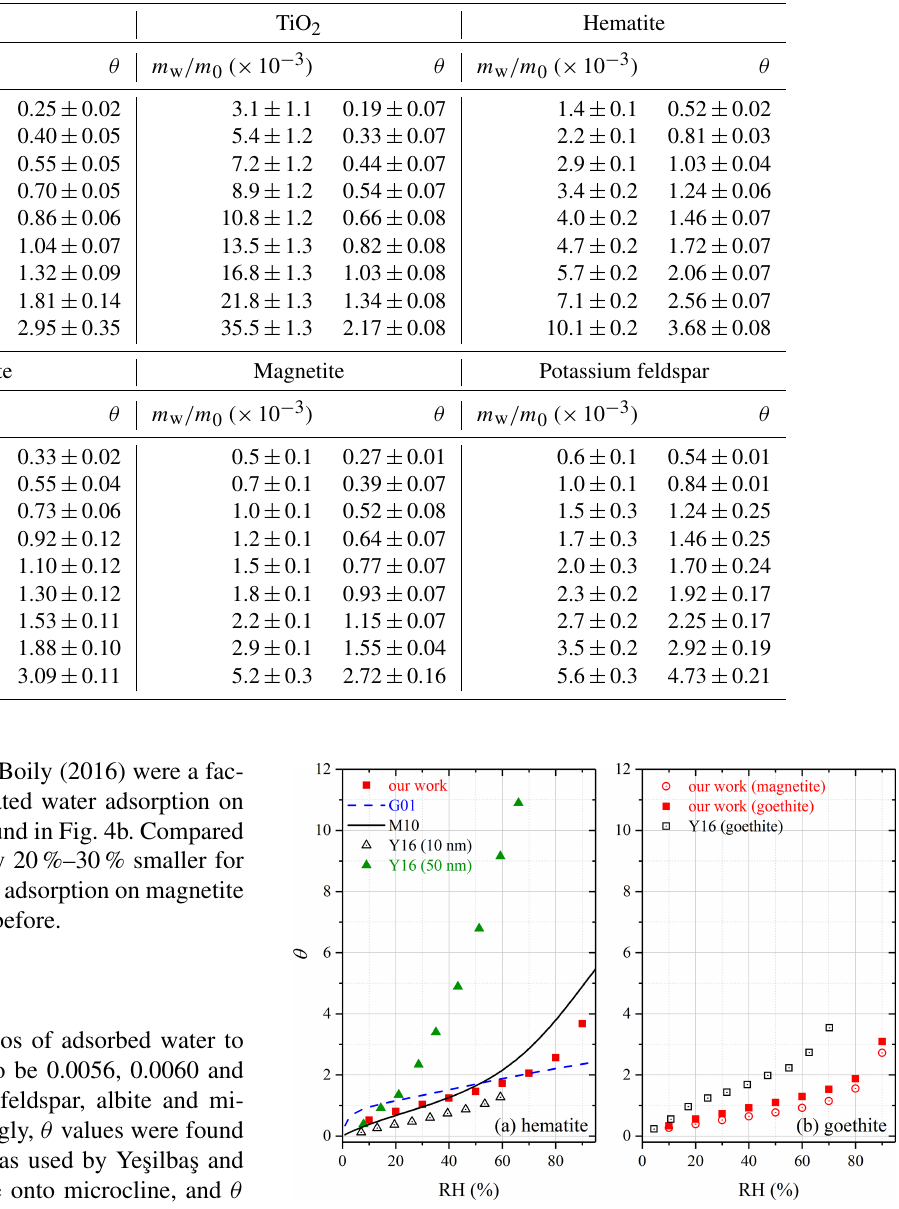
Figure 4. Comparison of surface coverages of adsorbed water ( θ ) measured in our work with those reported in previous studies for (a) hematite and (b) goethite ( θ values measured in our work for magnetite are also plotted). G01: Goodman et al. (2001); M10: Ma et al. (2010a); Y16: Ye¸silba¸s and Boily (2016).